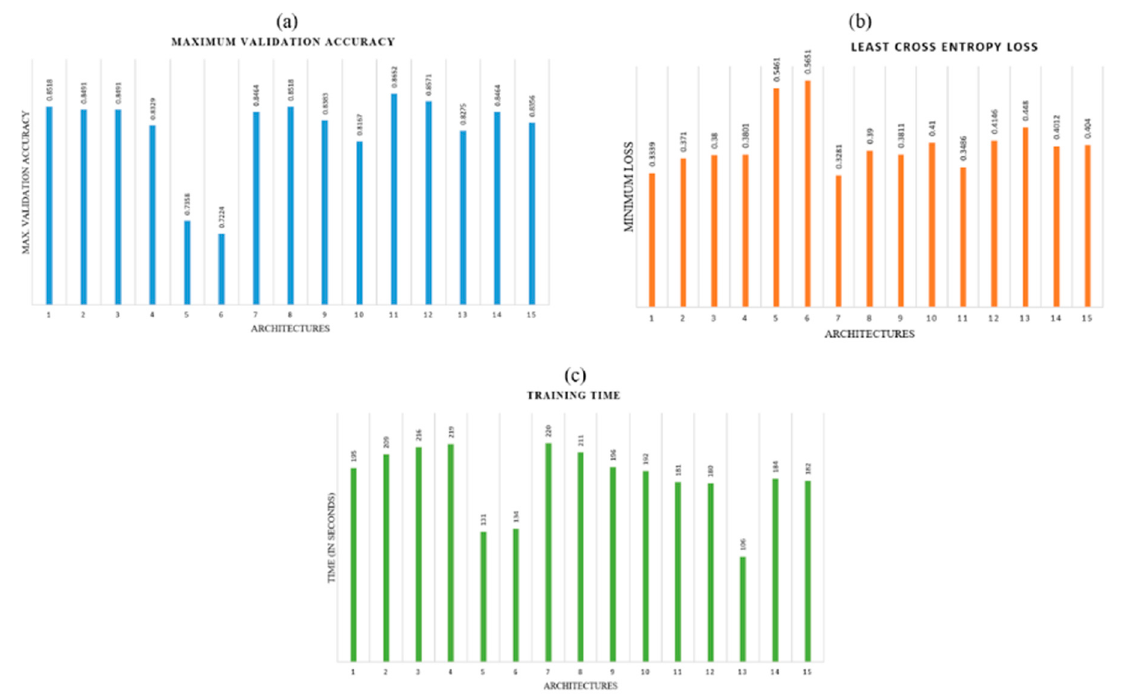
Figure 5. ( a ) Maximum validation accuracy of each CNN model, ( b ) least validation cross-entropy loss of each CNN model, and ( c ) training time (in seconds) of the CNN model.